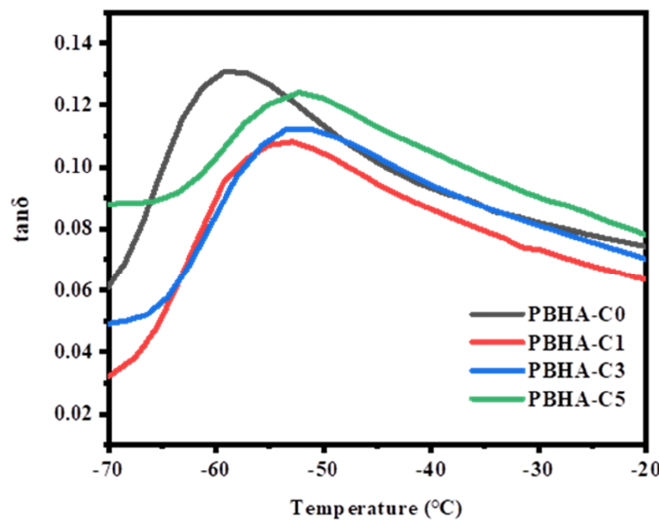
Figure 5. Tan δ of PBHA-Cn copolymers as a function of temperature.